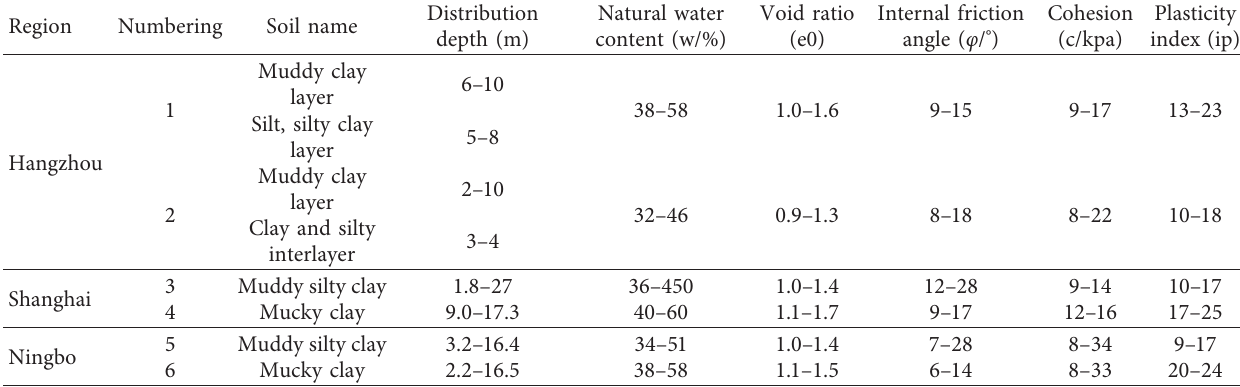
Table 1: Physical and mechanical parameters of soft soil in three places.